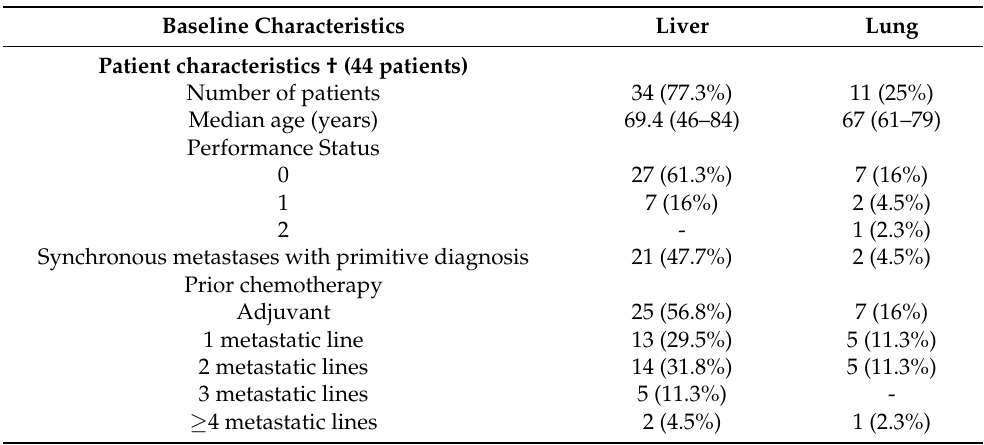
Table 1. Baseline characteristics of patients. Median values [ranges] are shown. Synchronous = time delay with primitive diagnosis ≤ 4